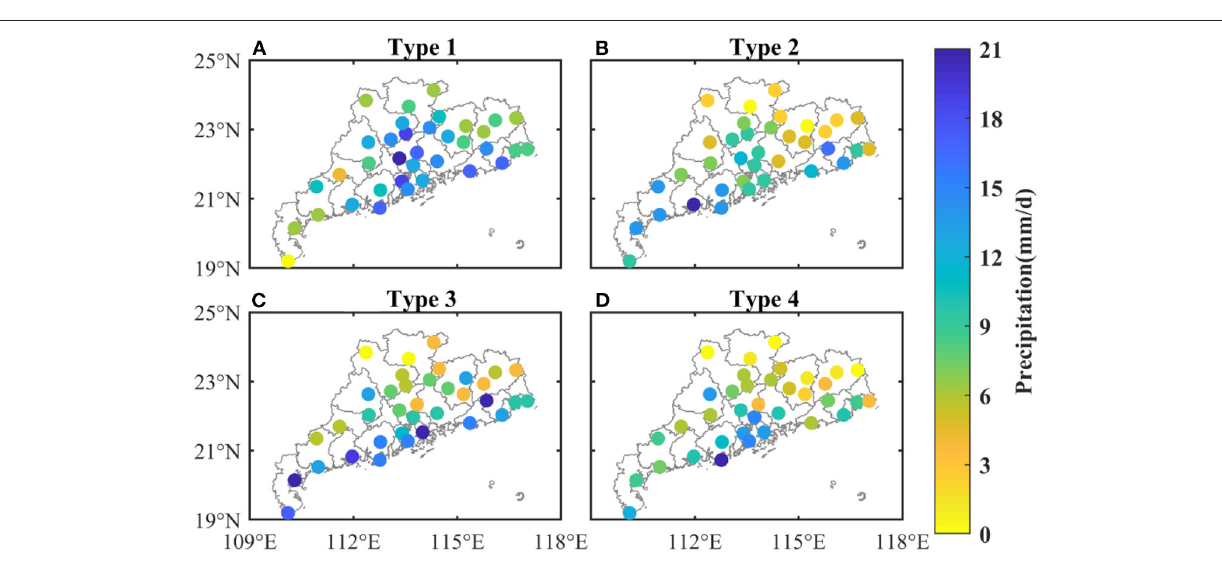
on the east side; Type 3 is the eastern subtropical high type (frequency:13.26%), in which Guangdong Province is to the west of the Western Pacific subtropical high. The dominant wind direction in Guangdong Province is southwesterly and the wind speed is high; And Type 4 is the northern low-pressure type (frequency: 6.96%), in which Guangdong Province is located to the south of low pressure, the dominant (but low) wind speed